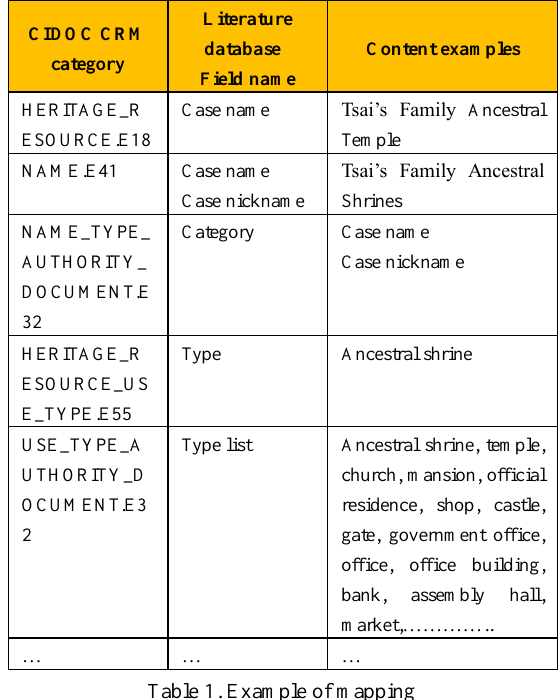
Table 1. Example of